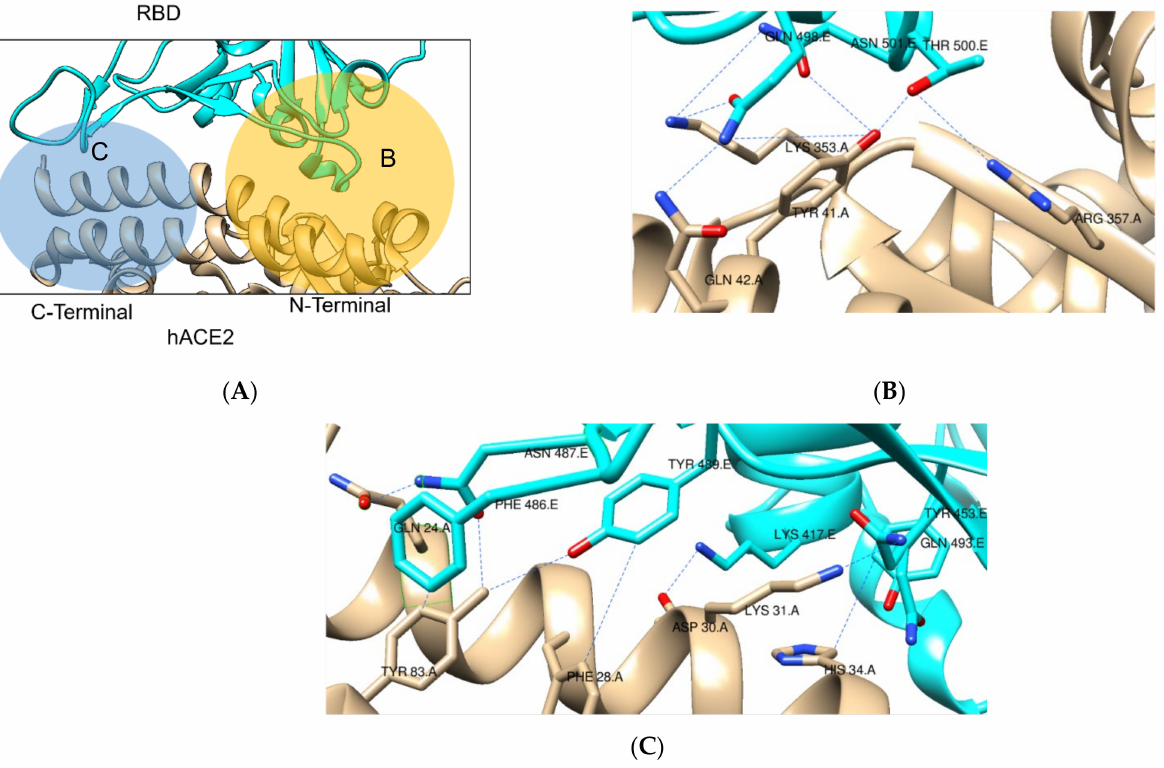
Figure 6. Interface between SARS-CoV-2 S protein RBD (cyan) and hACE2 (tan), in the S protein/ACE2 interaction without mutations structure (PDB 6M0J). ( A ) Full view of RBD—hACE2 interface ( B ) N-terminal portion of the α 1 helix with a network of H-bonds ( C ) C-terminal interactions, with π -stacking interactions, h-bonds and Van der Waals forces